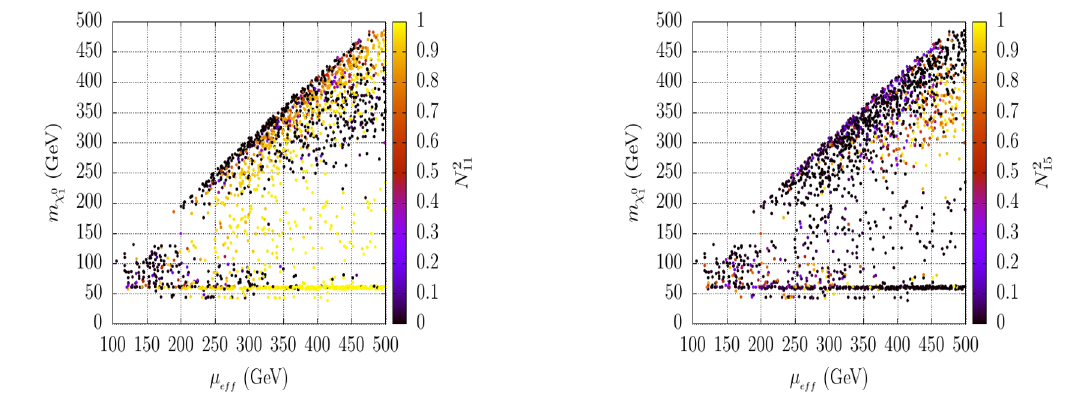
plane showing points that pass all relevant constraints from Figure 1. Scatter plots in µ eff − m χ 0 1 NMSSMTools (which include various collider and DM constraints), HiggsBounds and HiggsSignals . Variations of the bino ( N 2 , left) and the singlino ( N 2 , right) contents in the LSP (DM) are indicated 11 15 via the